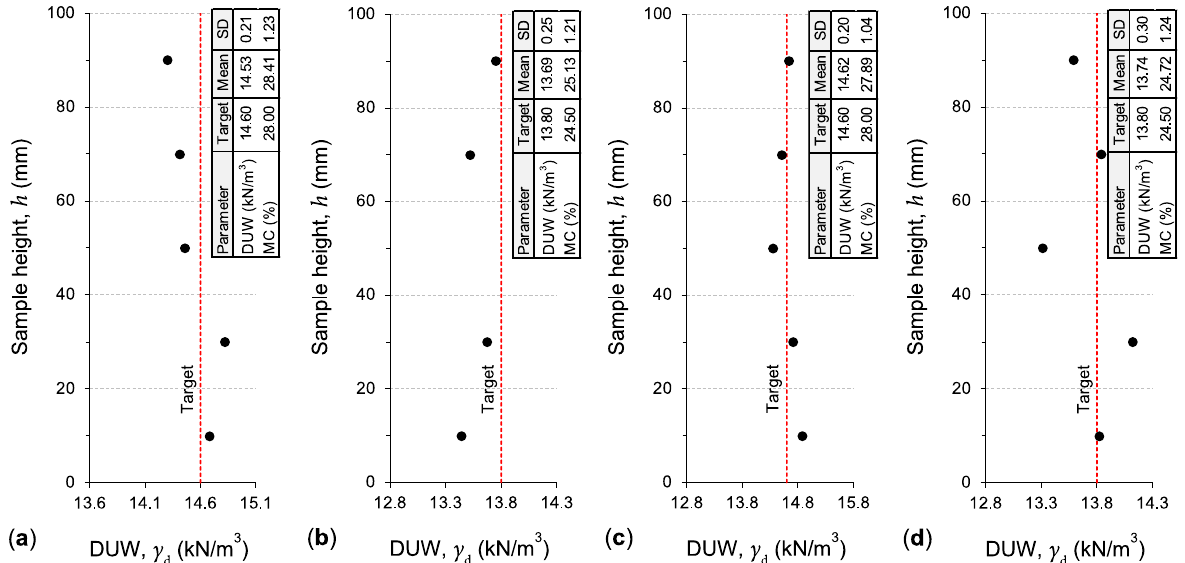
Figure 4. Variations of the DUW parameter along the height of representative SPE-compacted samples: ( a ) R 0 S 0 T 0 ; ( b ) R 10 S 0 T 0 ; ( c ) R 0 S 15 T 0 ; and ( d ) R 10 S 15 T 0 .